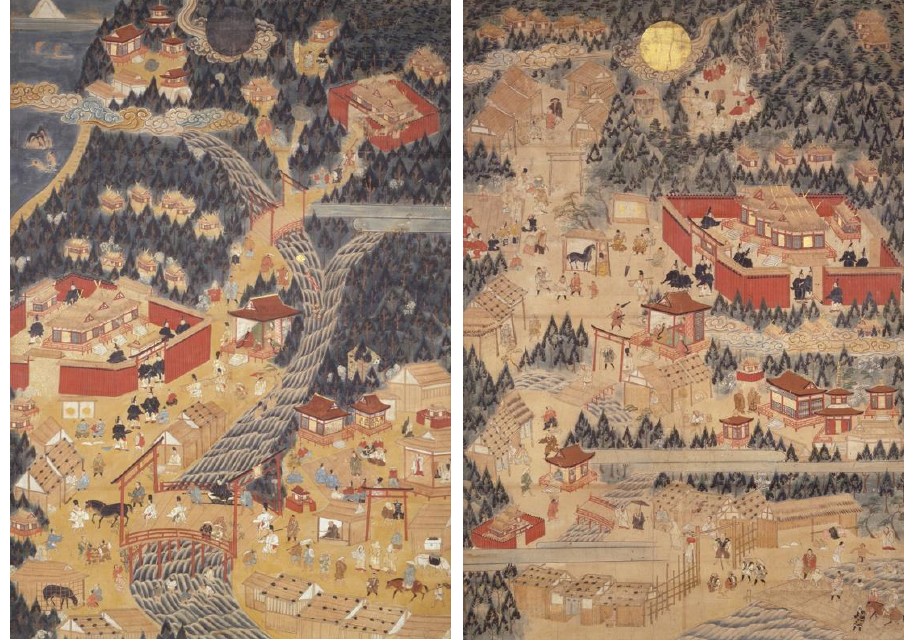
Figure 15. Ise Pilgrimage Mandala , 17th century, pair of hanging scrolls, ink and colors on paper, each 50 × 34 3/8 in (127 × 87.3 cm). Mitsui Bunko, Tokyo.